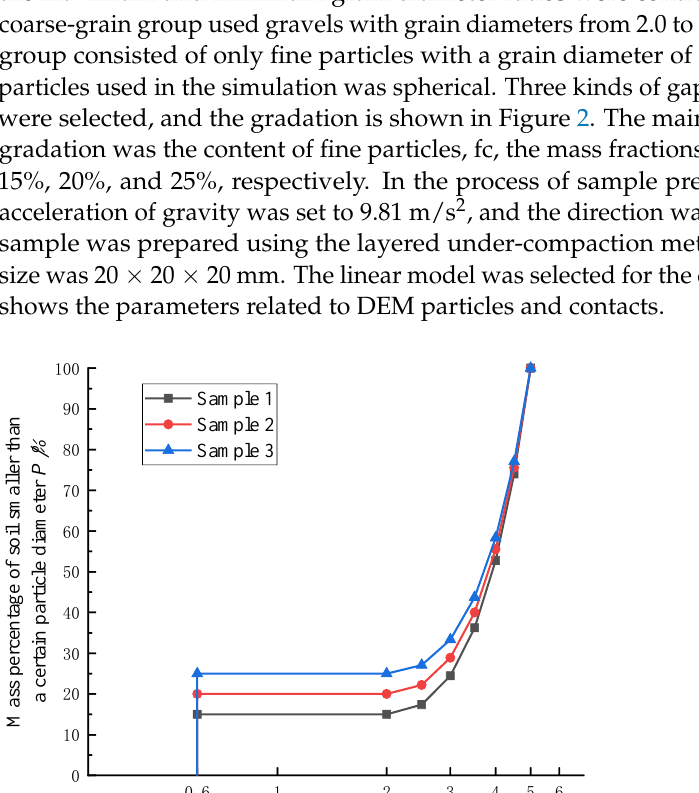
( b ) Figure 3. Numerical model of particle flow: ( a ) gradation sample, ( b ) fluid elements, and measure- ment regions. 3.2. Erosion Simulation Test Firstly, the parameter of the fine particle initiation rate was defined to describe the erosion effects of different seepage velocities, and its value is the percentage of the number of slightly moving particles along the seepage direction relative to the number of all